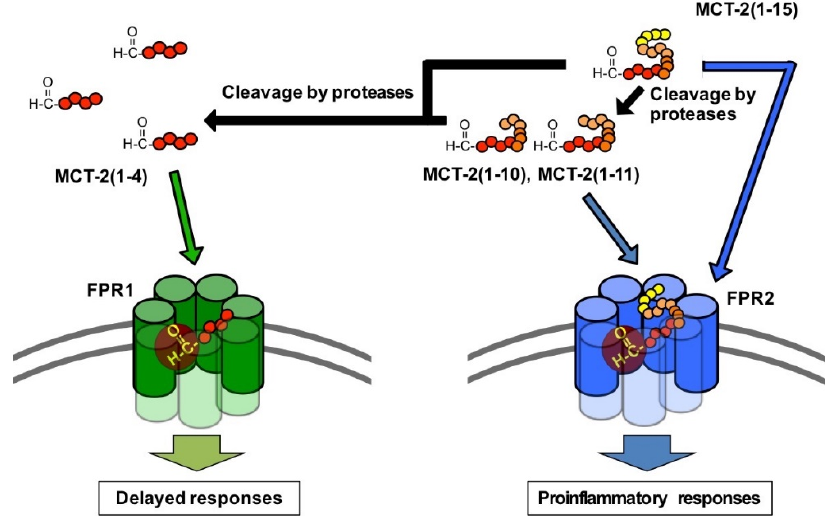
Figure 8. Proposed mechanisms of innate immune responses involving MCT-2(1–15). MCT-2(1–15) released from damaged cells firstly activates FPR2 to induce proinflammatory responses. Released MCT-2(1–15) is then degraded over time to produce MCT-2(1–4), and the resultant MCT-2(1–4) activates FPR1 to promote delayed responses, which may be related to resolution and wound healing/tissue regeneration. See the “Discussion” in detail.